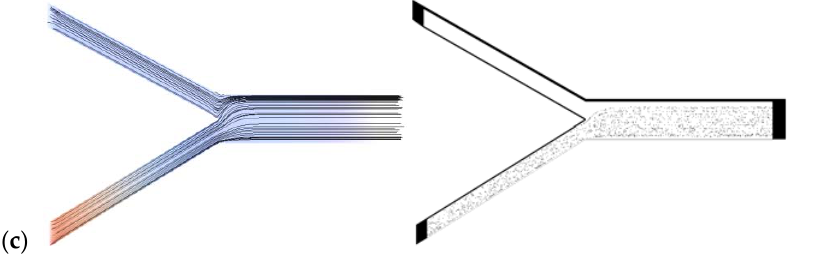
(cid:3404) 20 , (cid:3023)(cid:3030)